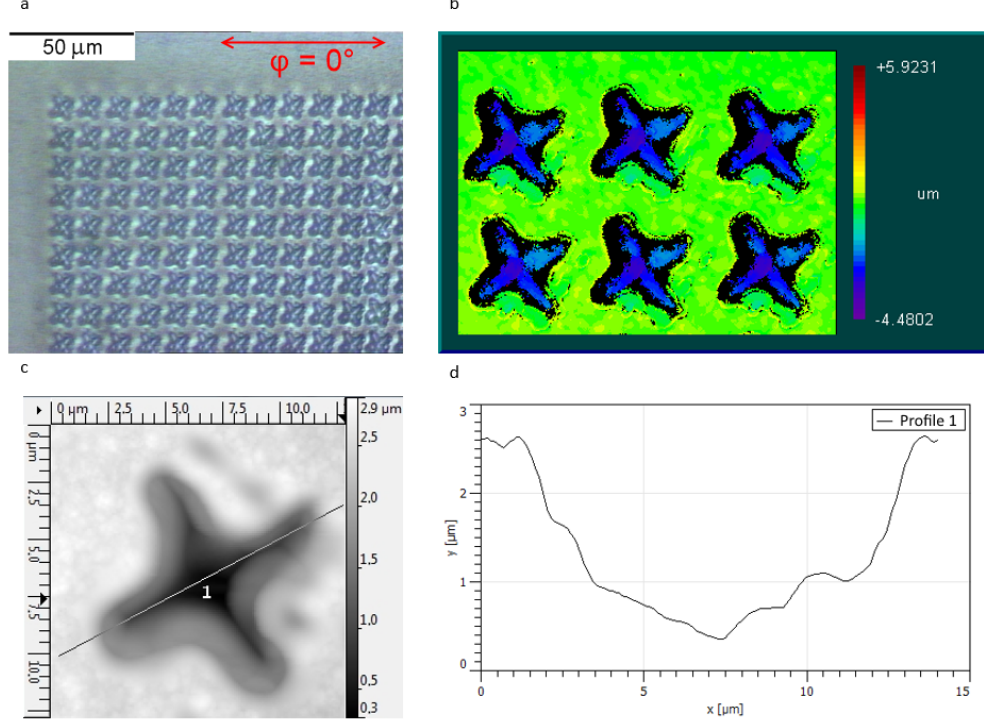
Figure 2. Image of a periodic structure, obtained with an optical microscope ( a ); interference micro- scope ( b ); scanning probe microscope ( c ); the profile of the chiral element measured by scanning the probe microscope ( d